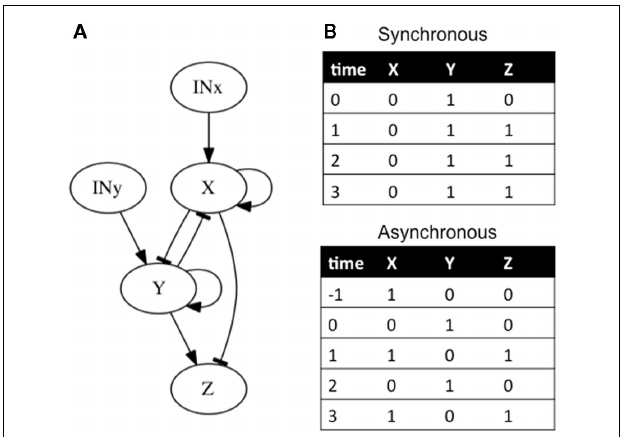
FIGURE 5 | Subgraphs to be inferred with epistasis analysis. As explained in the main text, these networks yield different results if we add a temporal dynamic analysis. (B) The possible attractors reached from the same condition are shown. If a synchronous updating of the gene states is assumed, the system reaches a fix-point attractor, while with an asynchronous updating the system reaches a periodic attractor.The logical rules of the motif are: (A) x = (IN x ∨ x ) ∧ (cid:4) y , y = (IN y ∨ y ) ∧ (cid:4) x , and z = (cid:4) x ∧ y .